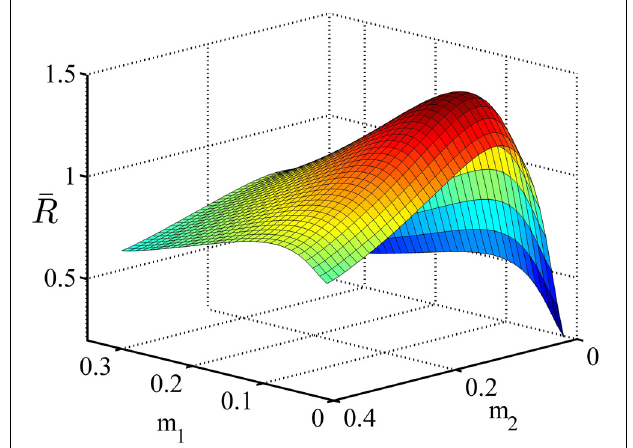
FIGURE 10 | The average reward rate as a function of the mean of the Gaussian policy in state 1, m 1 , and in state 2, m 2 . This function is computed using the method described in Supplementary